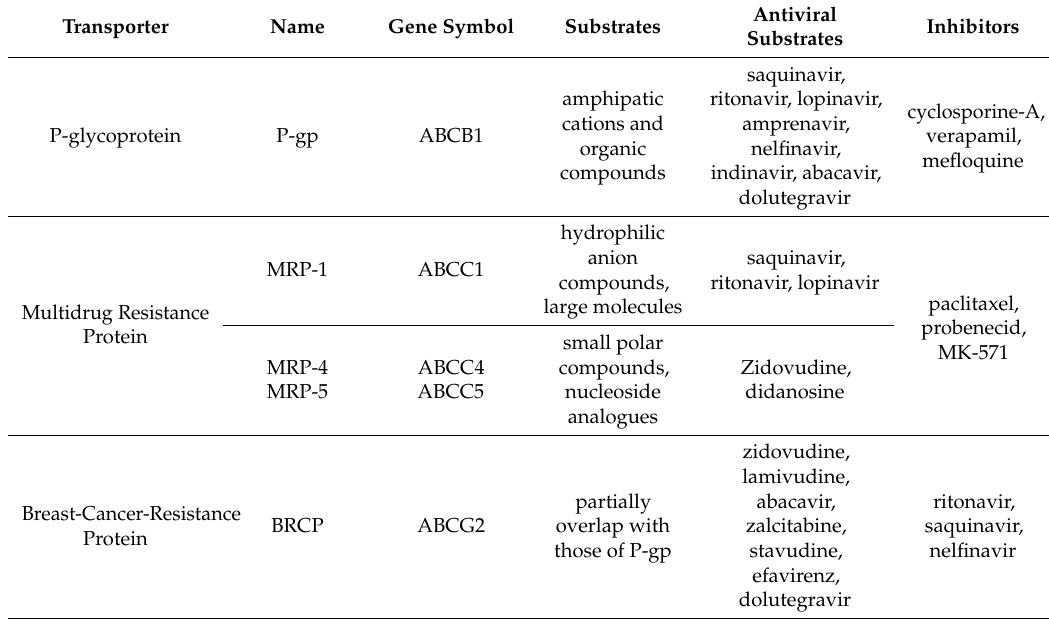
Table 1. The ATP-binding cassette (ABC) efflux active transporters currently known to interact with antiviral